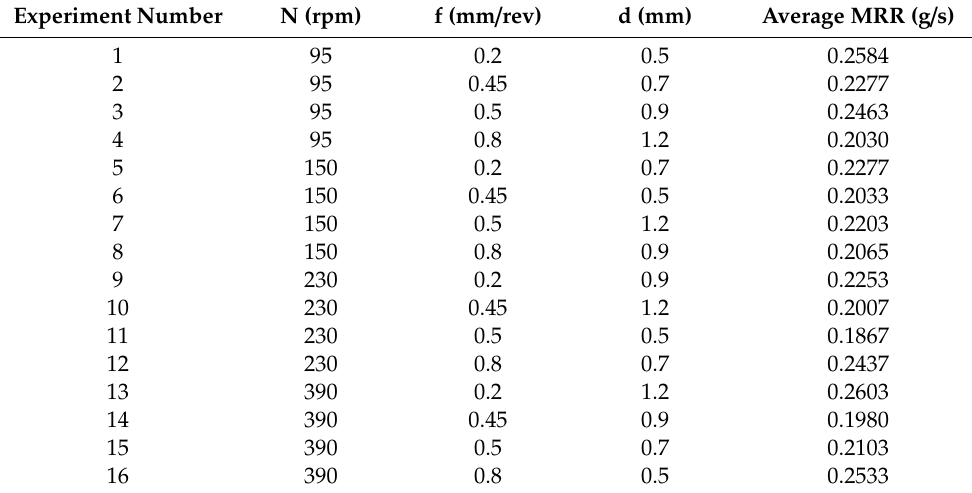
Table 2. Experimental results [1] .